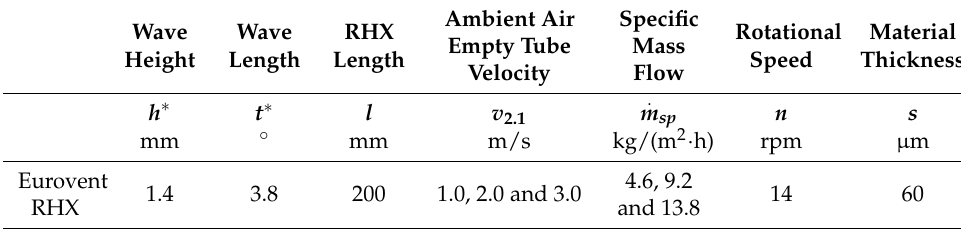
Table 4. Eurovent model P_17-1100-WZV.